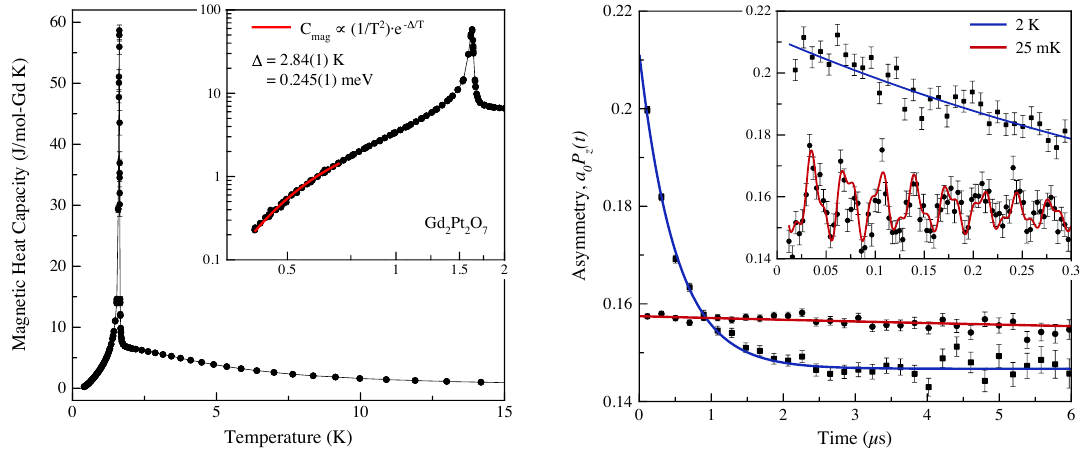
FIG. 3. The low temperature magnetic heat capacity of FIG. 4. The muon decay asymmetry Gd 2 Pt 2 O 7 out to 6 µ s at Figure 14. (color online) Heat capacity (left) and muon spin relaxation measurements (right) on Gd 2 Pt 2 O 7 , showing a first order phase transition at T N = 25 mK and 2 K. Below T N = 1 . 6 K, the relaxation rate steeply Gd 2 Pt 2 O 7 , showing clear evidence for long-range magnetic ordering. From Ref. 1 . 6 K. Inset: The low temperature heat capacity, between 0.4 K increases such that the early time asymmetry falls outside of and 2 K on a logarithmic scale. Below 0.75 K, the heat capac- our time window at 25 mK. The fits to the data are given by ity is well-described by an exponential decay, given by the red curve, indicating the presence of a gap in the spin excitation spectrum. The fitted value of the gap is  = 0 . 245(1) meV.